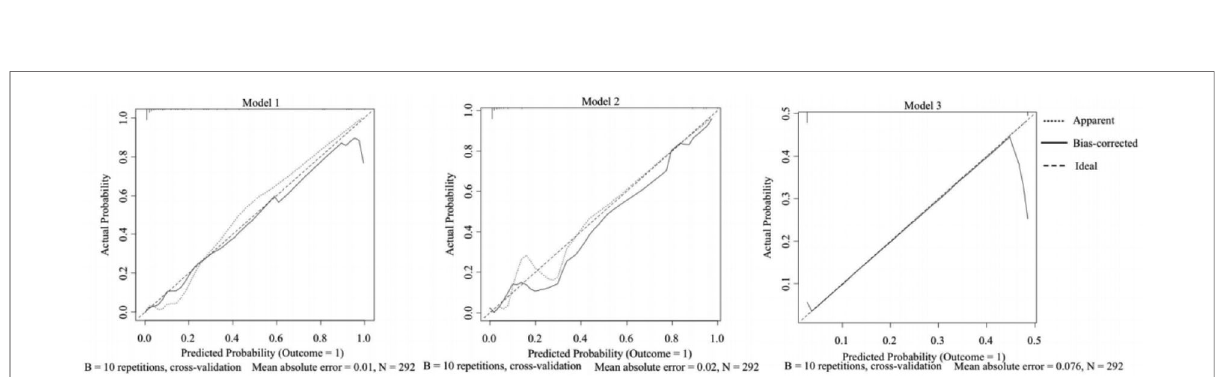
FIGURE 5 Calibration plots for three models: training cohort. The horizontal axis is the probability of a predicted phototherapy failure. The vertical axis is the probability of an actual event. The bias-corrected curve is the calibration curve after 10-fold cross-validation of a model. The 45° reference line represents the ideal calibration. The closer a solid line is to the reference line, the more probable the prediction is, showing better calibration of the